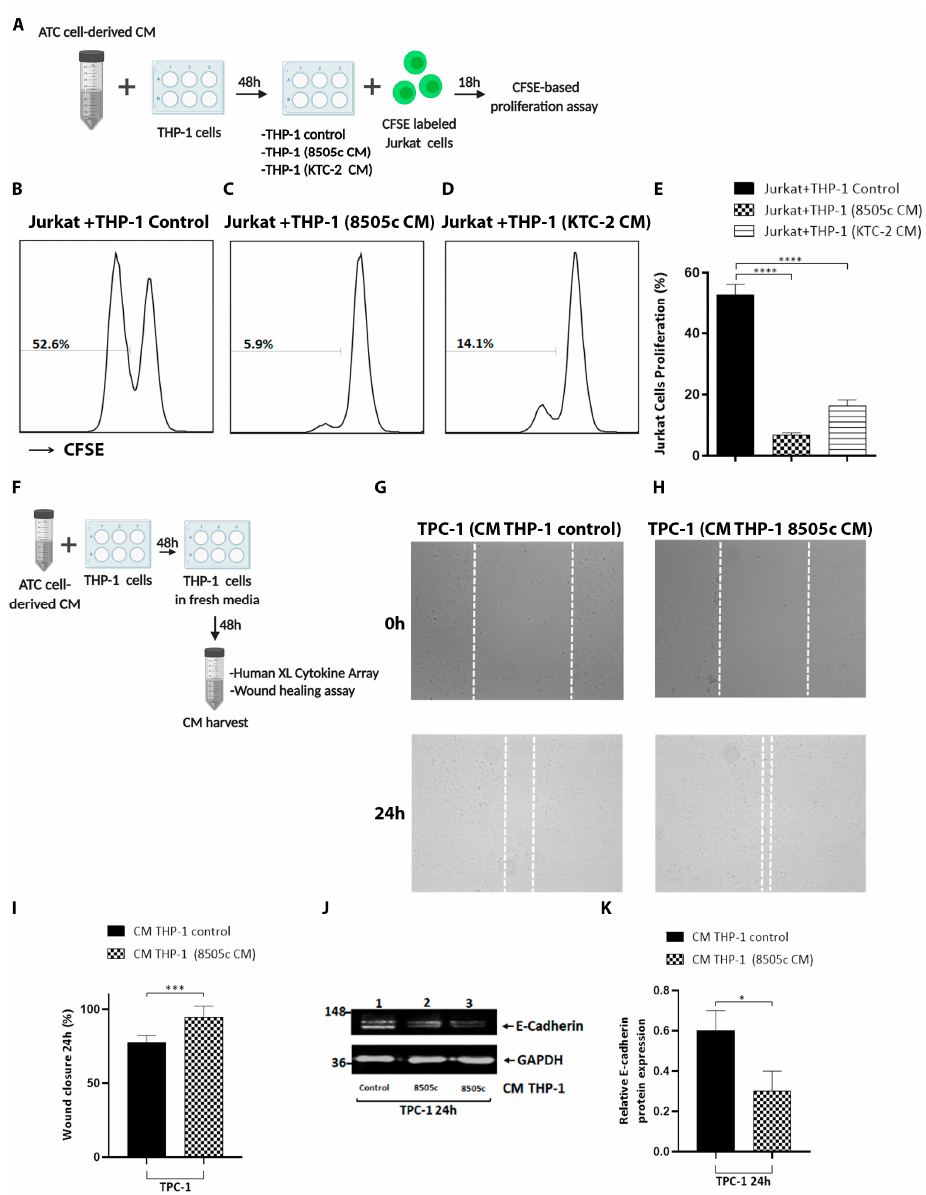
Figure 3. Tumor-educated macrophages by soluble factors secreted by ATC cells exert tumor-promoting functions by decreasing T cell proliferation and increasing thyroid cancer cell migration. ( A ) Schematic of experiment on Jurkat cell proliferation. THP-1 cells were incubated with complete media containing 5% FBS (THP-1 control) or treated with 100% of ATC cell-derived CM for 48 h. T cells were labeled with CFSE and co-cultured with activated macrophages for 18 h. ( B – E ) Determination of T cell proliferation by flow cytometry. CFSE-labeled Jurkat cells were co-cultured with THP-1 cells grown under normal conditions (THP-1 control) ( B ) or pretreated for 48 h with 8505c-derived CM ( C ) and KTC-2-derived CM ( D ) at a ratio of 0.5:1 for 18 h. Representative histograms ( B – D ) and quantification of percentage of T cells after the co-culture ( E ) are shown. ( F ) Schematic representation of CM preparation from THP-1 cells. Complete media containing 5% FBS 100% or CM from 8505c cells were used for the treatment of THP-1 cells for 48 h. The medium was discarded and then incubated with fresh medium. After 48 h, CM from THP-1 cells were collected and used (100%) to